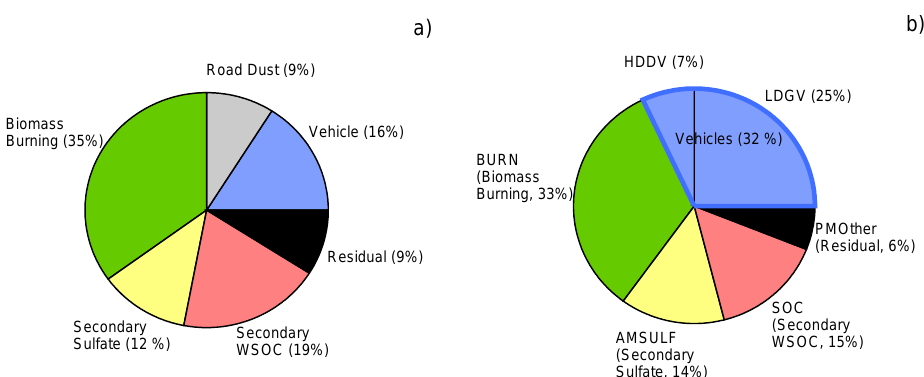
Figure 8. Annual aggregate contributions of different sources identified by PMF (a) and CMB method (b) to the water-soluble DTT activity of ambient PM 2 . 5 in urban